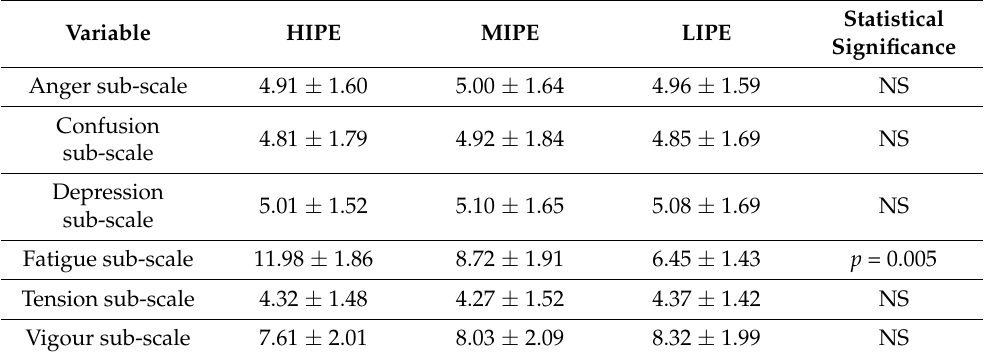
Table 2. Scales of the BRUMS scale broken down according to the